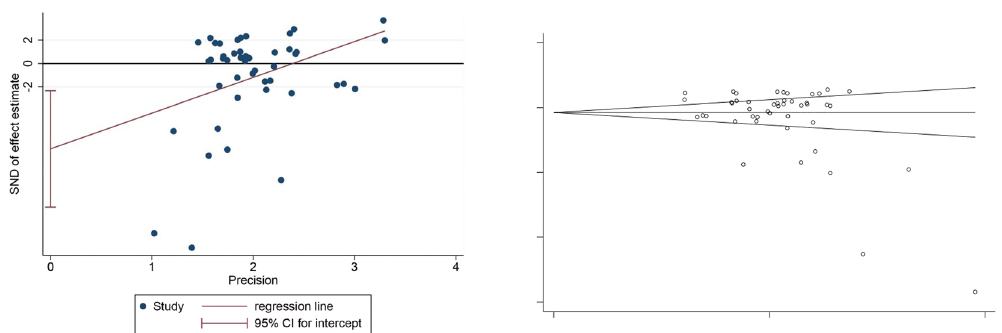
Figure 12. The Egger’s and Begg’s test of objective response rate (CR +